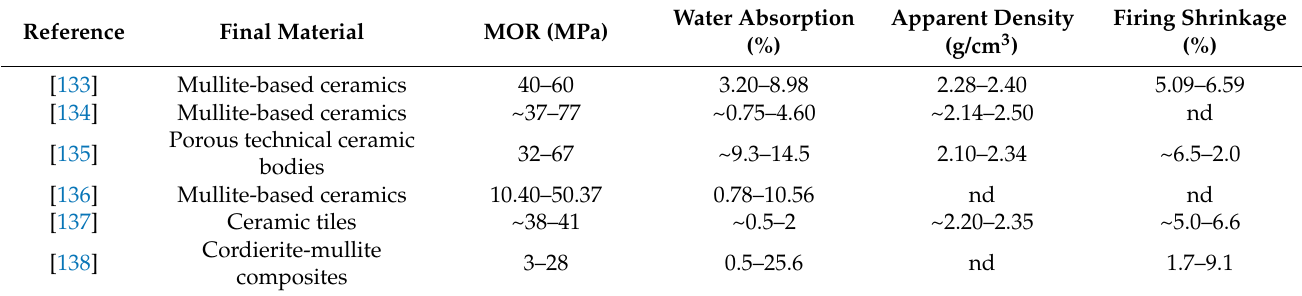
Table 17. Technological properties of mullite-based materials developed from primary kaolin industry waste.